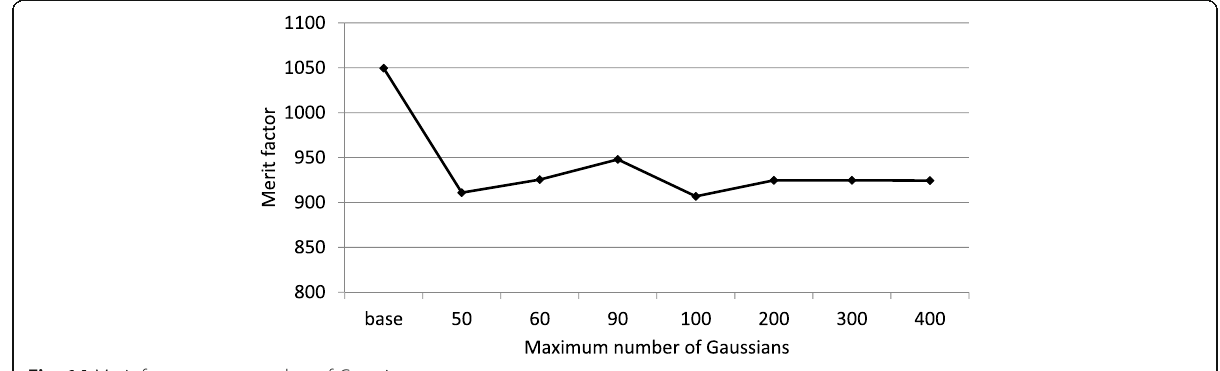
Fig. 14 Merit factor versus number of